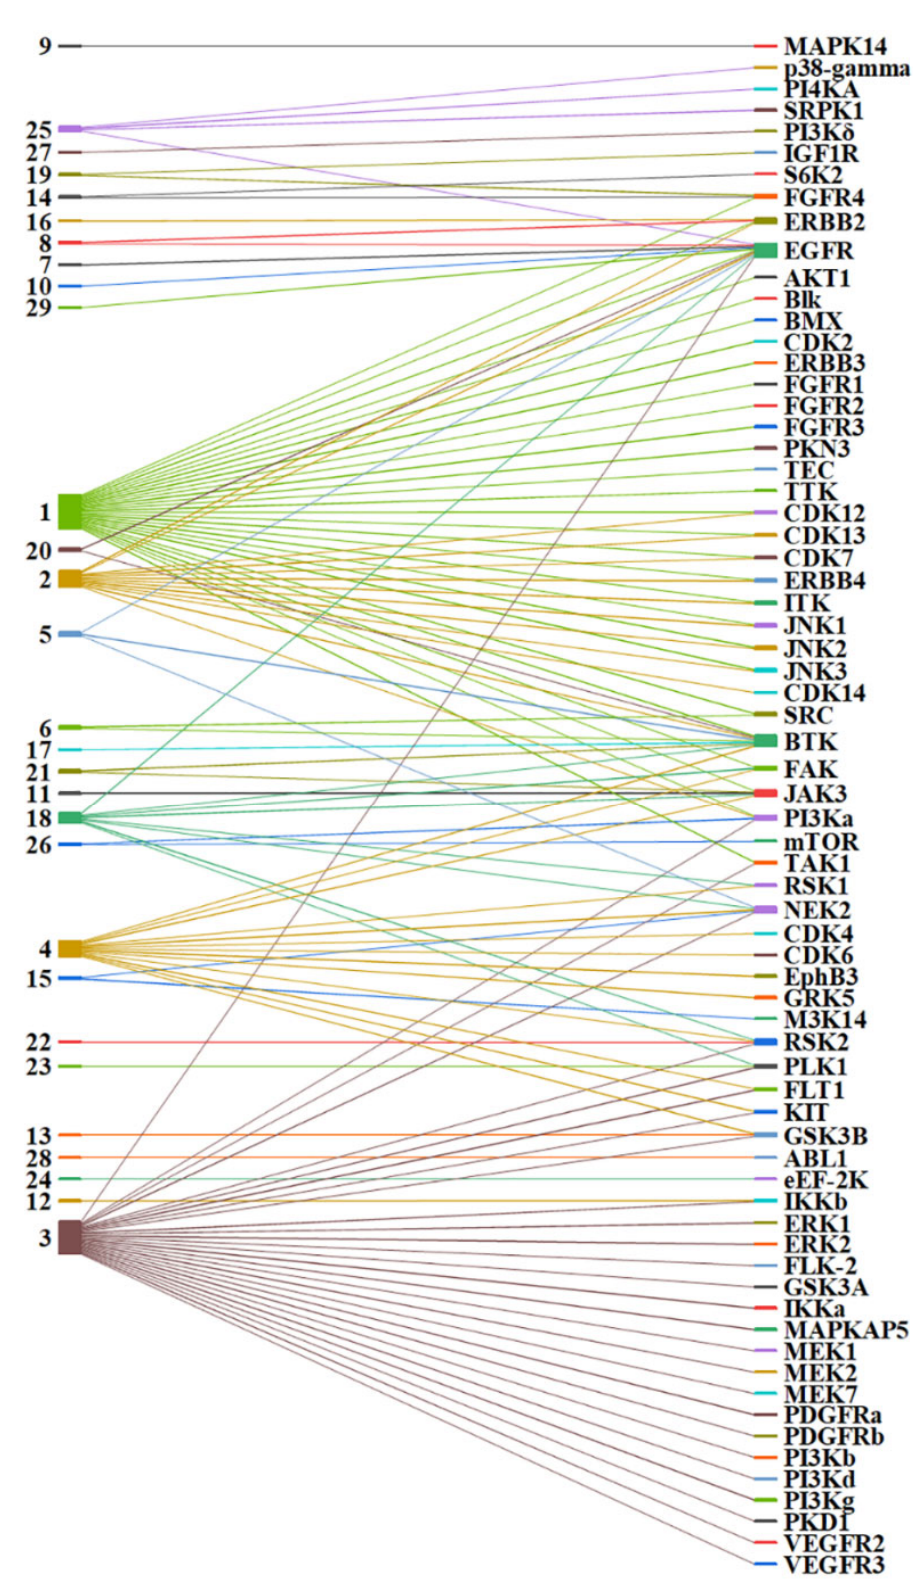
Figure 4. Warheads applied to different kinases.